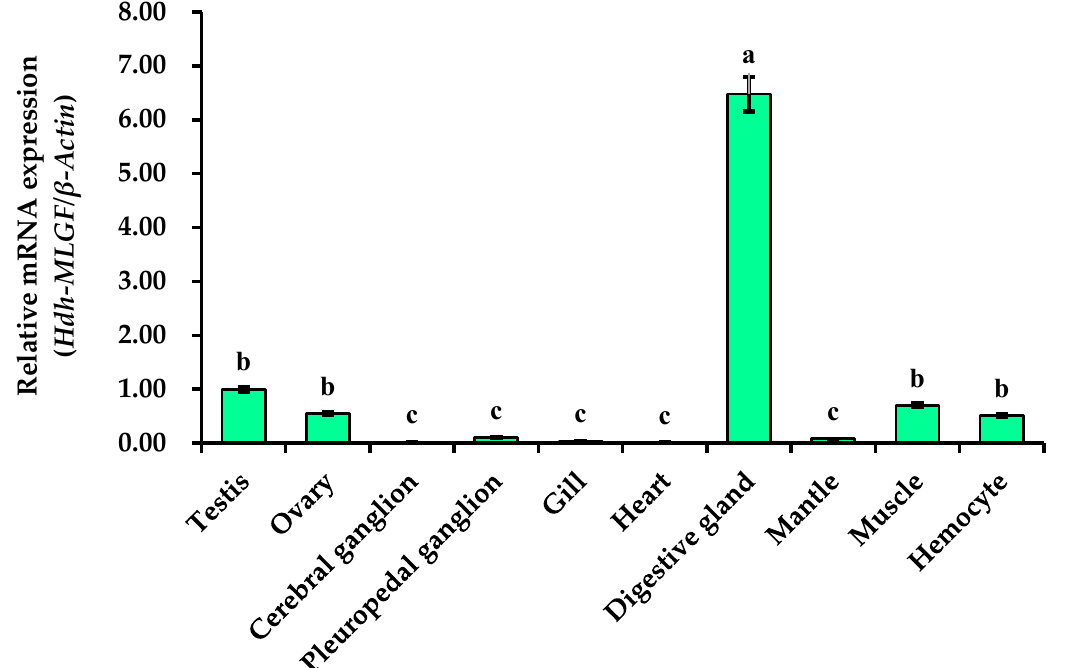
Figure 7. Expression of Hdh-MLGF/Hdh- β -Actin mRNA in different tissues of Pacific abalone, H. discus hannai. In graph, error bars indicate standard error and different letters above the bar indicate significance difference ( p < 0.05).